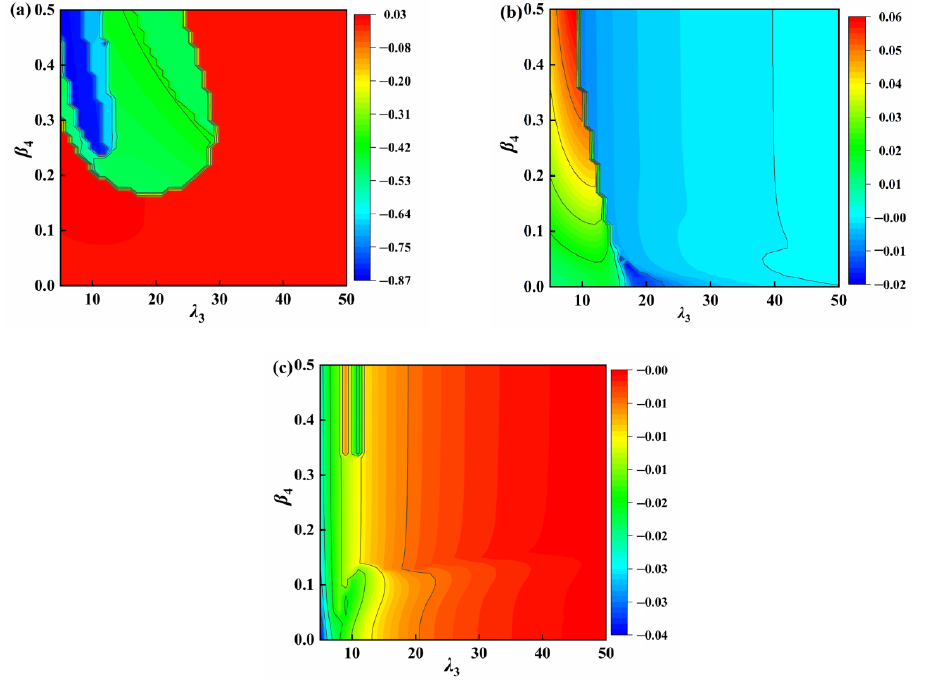
Figure 7. The resonant frequency change of the primary system as negative stiffness ratio β 4 and inertance ratio λ 3 under f e = 0.4 mm: ( a ) β 3 = 0.0027; ( b ) β 3 = 0.027; ( c ) β 3 = 0.27.